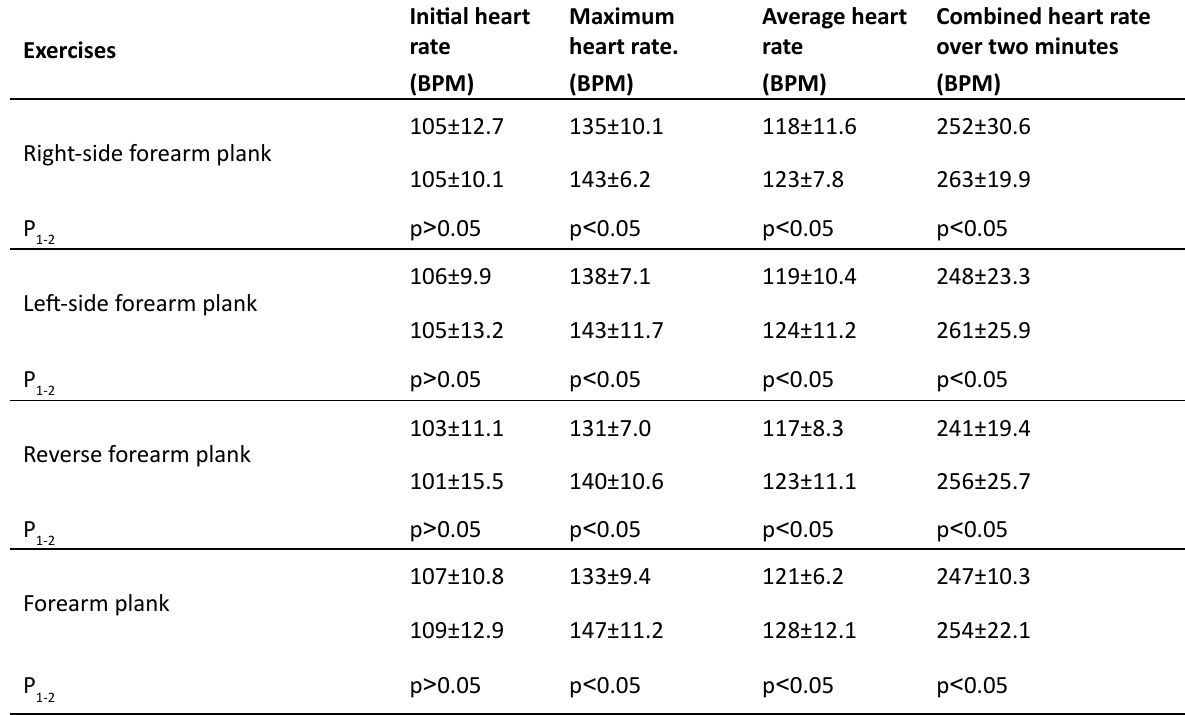
Table. Comparison of the strength exercises’ training effect on a student’s body in the static mode (top line) and in the isotonic mode (bottom line)